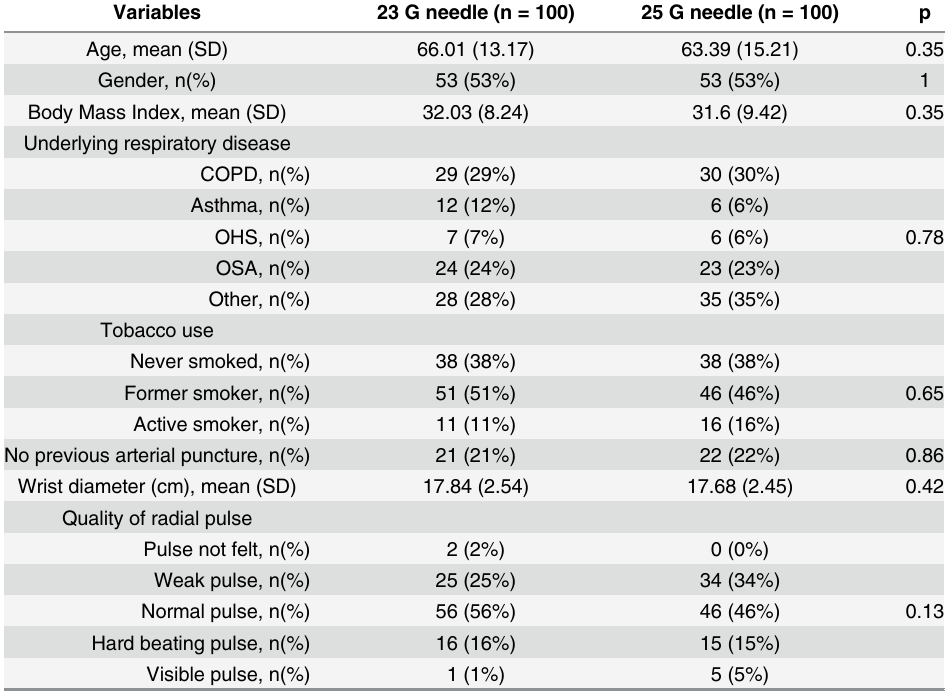
Table 1. Characteristics of patients.